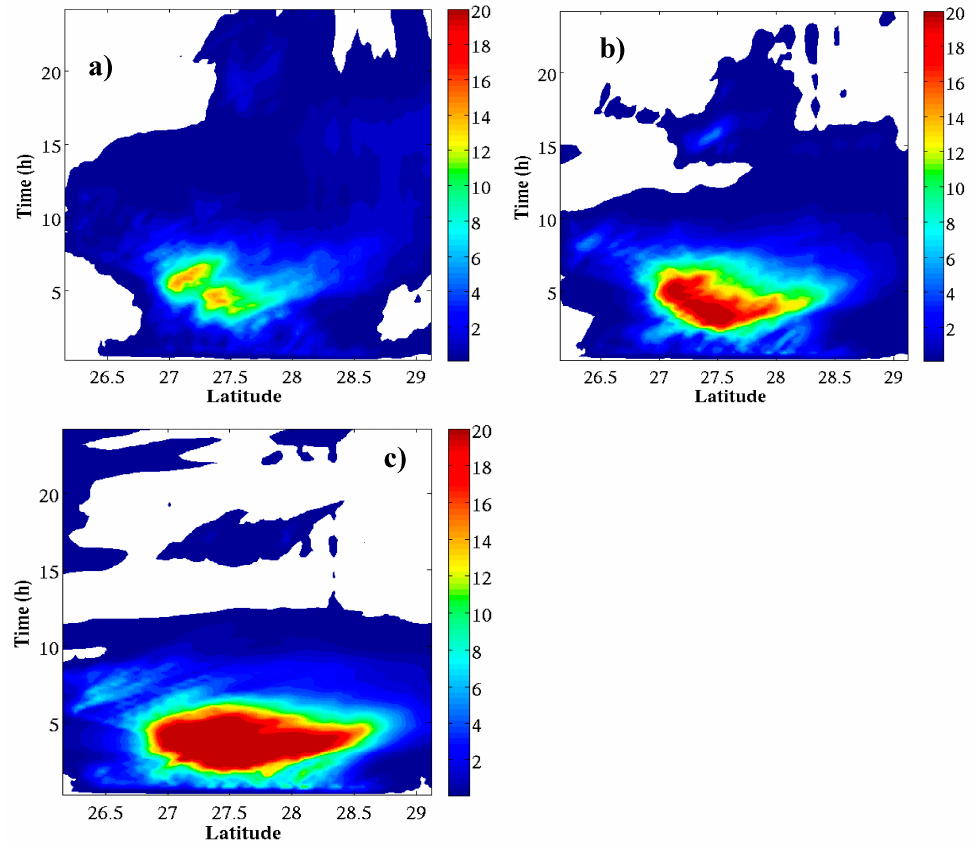
Figure 4. Hovmöller diagrams for total condensate (g kg − 1 ) simulated for the ‘low’ aerosol concentration ( a ) Tctrl; ( b ) Tctrl + 5 °C; and ( c ) Tctrl + 10 °C. As explained in the text, this diagram